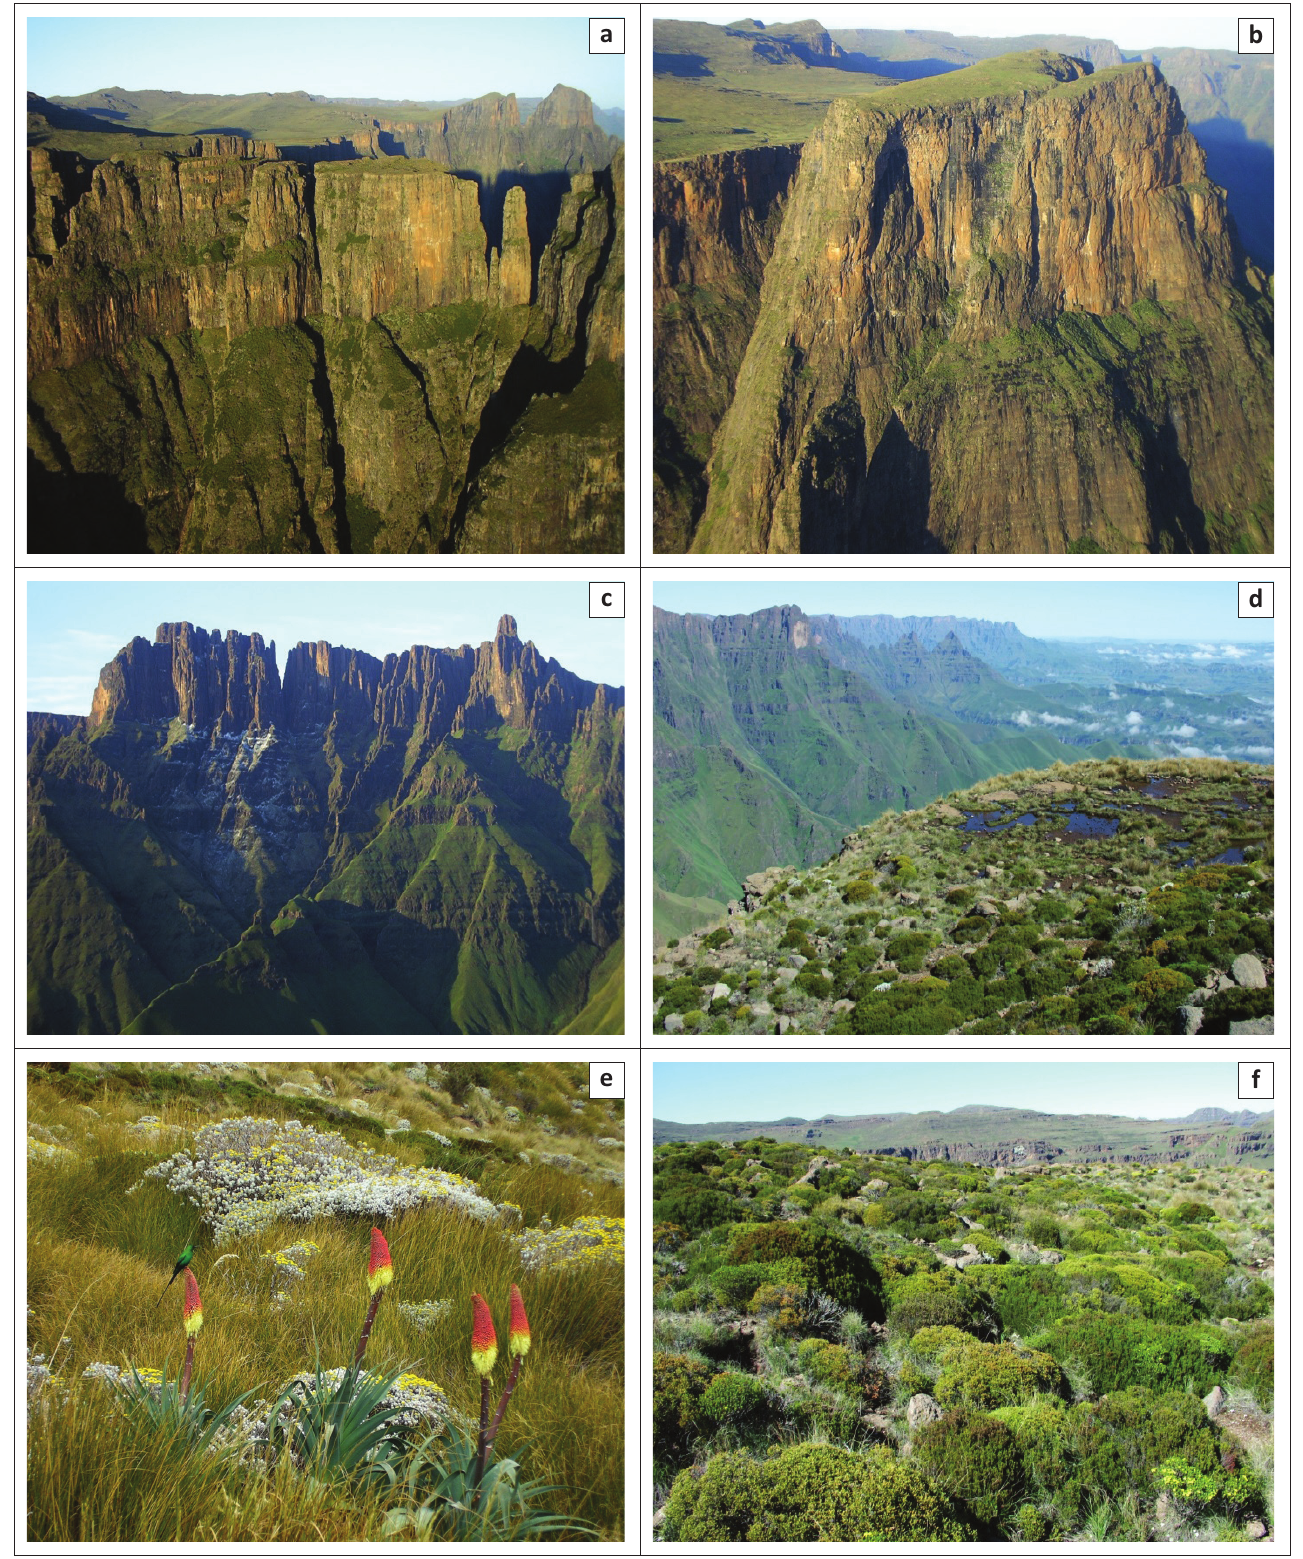
FIGURE 1: Photographs of Drakensberg peaks and inselbergs showing alpine plants on their summits. (a) Looking north, with Sentinel in the background on the skyline to the right, the finger-like Devil’s Tooth directly in front, Inner Buttress to the left, with an archipelago of smaller inselbergs and Eastern Buttress (3060 m) to the right. (b) Helicopter view west, of the escarpment with Sentinel in the foreground, the most northerly inselberg (3109 m – 3156 m), habitat for the endemic alpine grasses Pentaschistis exserta , Polevansia rigida and the near endemic Styppeiochloa gynoglossa . (c) The rugged topography of the Rockeries (3027 m), sprinkled with November snow and the prominent Mweni Peak (3099 m) on the right. (d) Temporary wetlands on Cathkin Peak (3154 m), habitat for the wetland endemics Aponogeton ranunculiflorus , Crassula peploides , Limosella vesiculosa and Rhodohypoxis rubella . (e) Alpine vegetation on Inner Horn (3005 m), showing a typical mix of grasses and shrubs, with a Malachite Sunbird ( Nectarinia famosa ) on Kniphofia caulescens , with Helichrysum trilineatum surrounded by tall, endemic bunch-grasses Merxmuellera drakensbergensis and M. stereophylla found on deep, basalt soils. (f) High altitude adapted cushion plant-forms of Passerina , Euryops and Erica shrubs, a response to freezing alpine conditions, on Cathkin Peak (3154